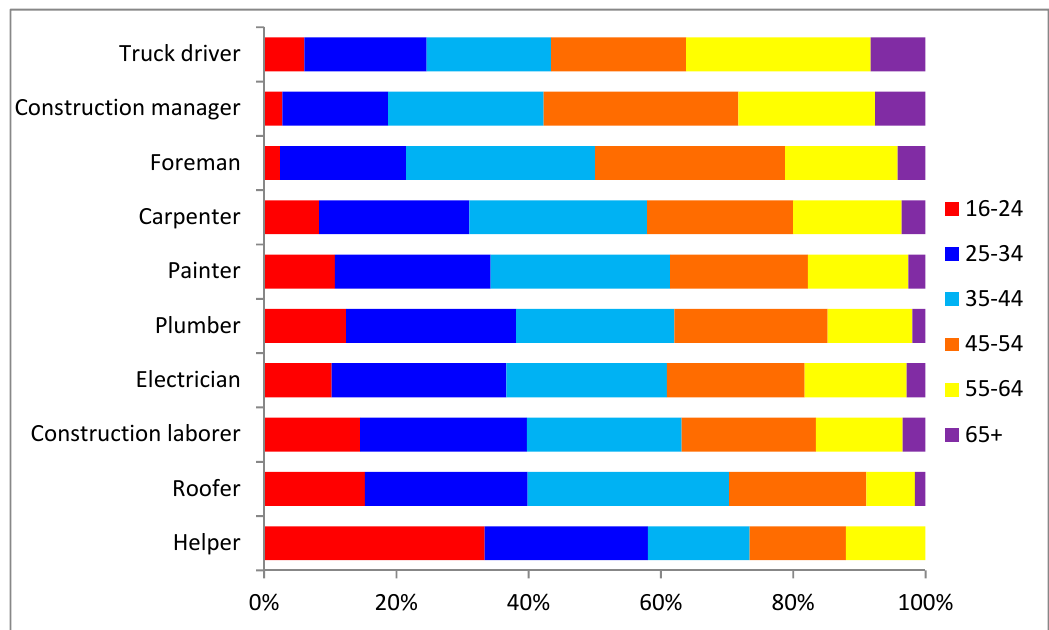
Figure 2. Age distribution among selected occupations in construction, 2017 (All employment).